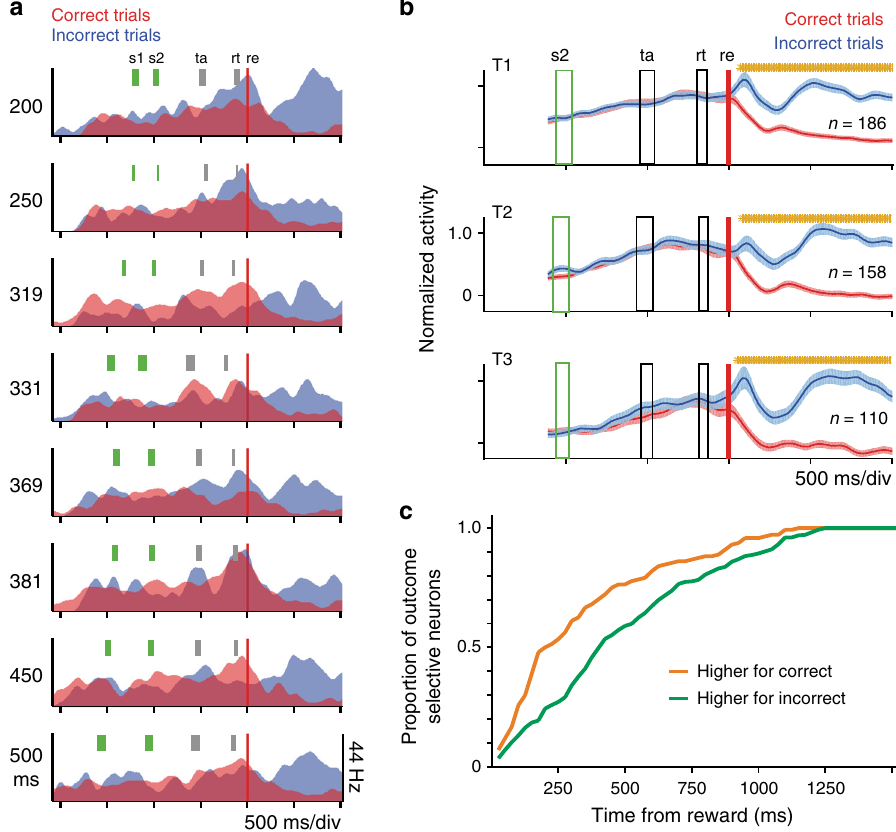
Fig. 8 Decision outcome neurons. a Example of a pre-SMA neuron with higher activity for incorrect and unrewarded trials during the intertrial interval. The activity was separated into correct (red) and incorrect (blue) trials. s1, s2, ta, and rt indicate the standard deviation for fi rst stimulus, second stimulus, targets and reaction time, respectively. b Population activity (mean ± SEM) of the neurons of monkey 2 whose fi ring rate is signi fi cantly larger for incorrect trials (blue function). Orange asterisks indicate: (1) t -test signi fi cant differences in non-overlapping sliding windows (over the population SDF, correct vs. incorrect, 95% bootstrap con fi dence interval, 100 iterations). The single cell ( a ) and the population activity ( b ) are aligned to the expected time of reward (re, red vertical line). c Cumulative distributions of the response onset latencies of the neurons selective for correct (orange) and incorrect (green) categorical decision outcomes during de intertrial interval. Note that the response onset latencies are shifted to the right for incorrect outcomes and are signi fi cantly larger for correct trials (Kolmogorov – Smirnov test, p <